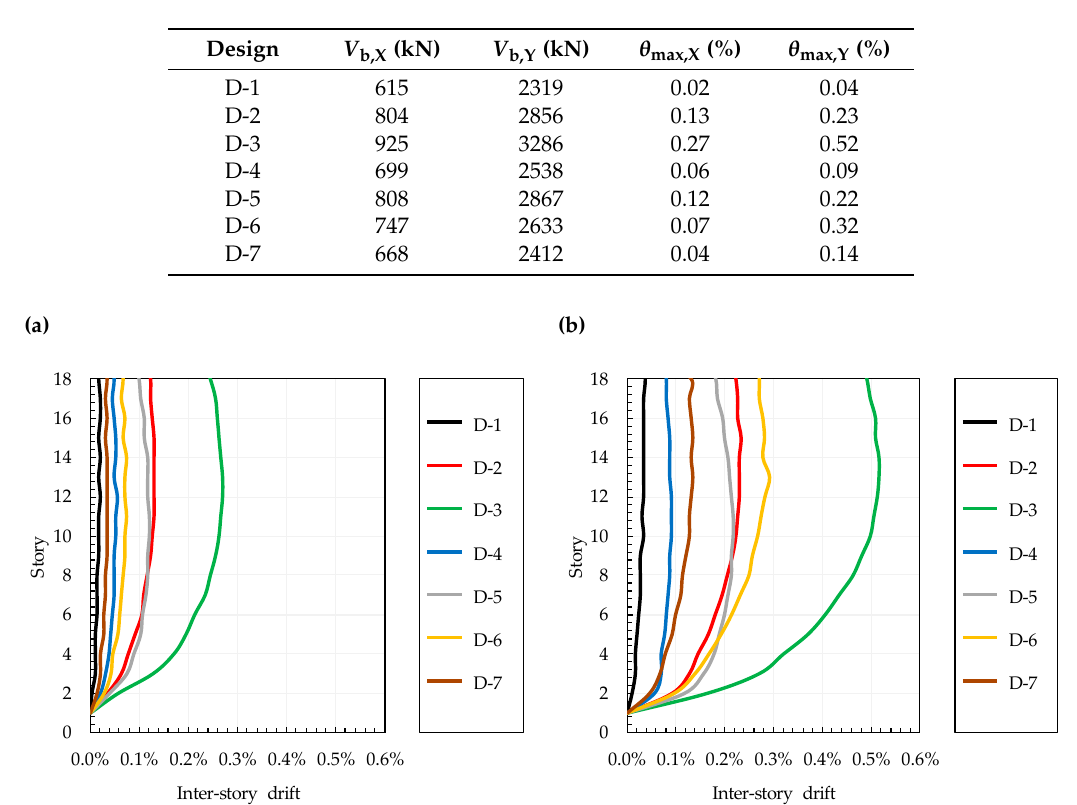
Figure 7. Inter-story drift profile for the X -direction ( a ) and Y -direction ( b ) under seismic loads. Table 4. Results from the dynamic wind analysis.